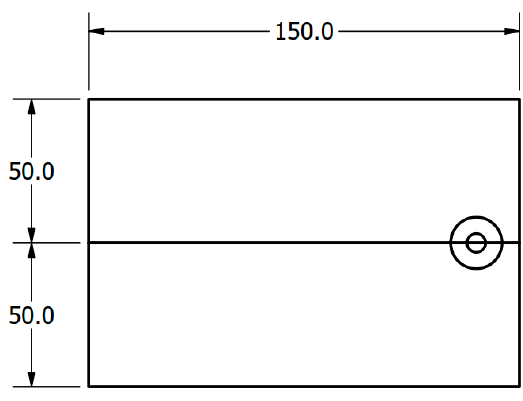
Table 9. Mechanical properties of Al 6061 ‐ T6 [121].